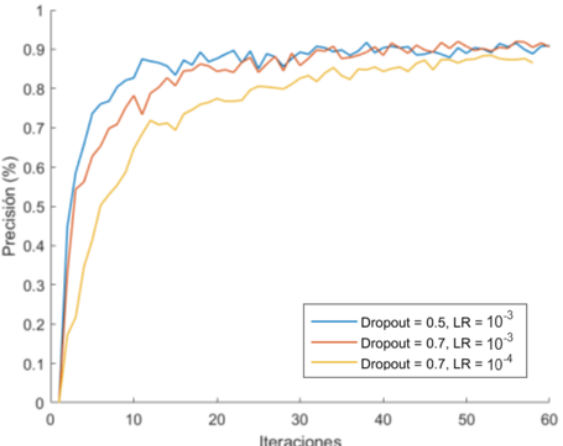
Figure 15. Dropout and learning rate effect.